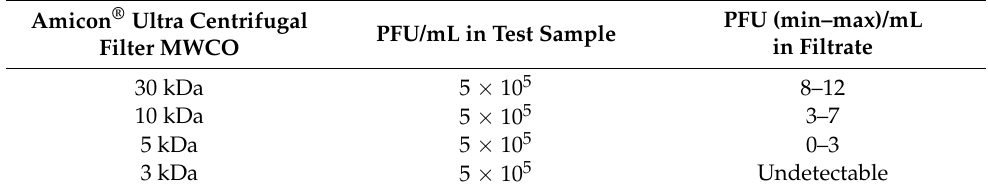
Table 1. Efficiency of ultrafiltration method in eliminating severe acute respiratory syndrome coronavirus-2 (SARS-CoV-2) from infected cell culture supernatants.